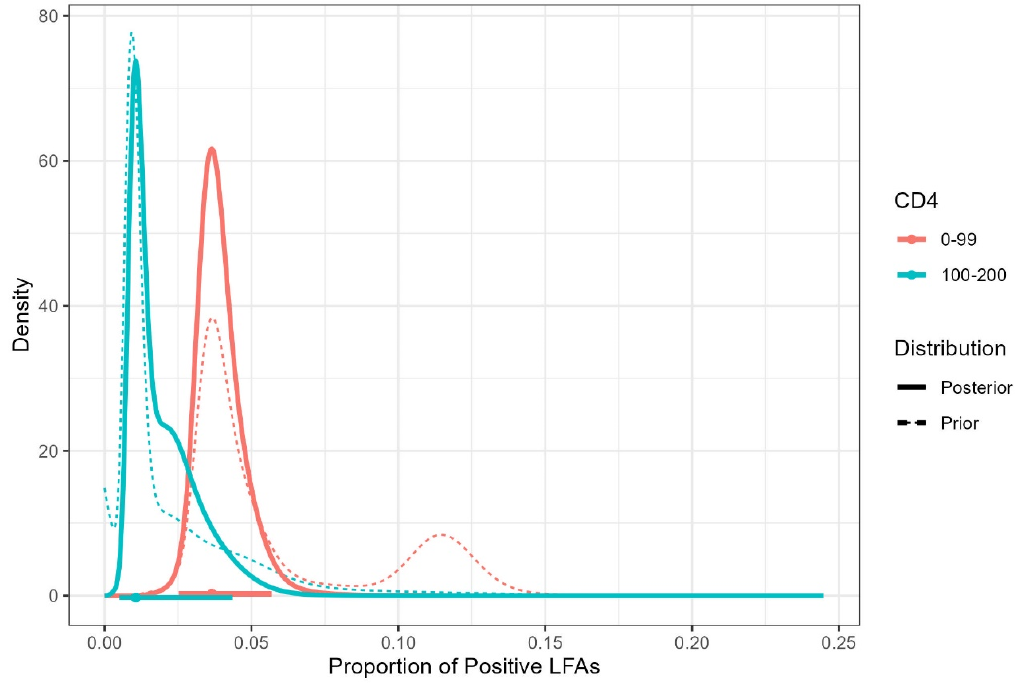
Figure 3. Prior and posterior densities of the proportion of positive LFAs with estimated prevalences and HPD credible intervals for each CD4 group .